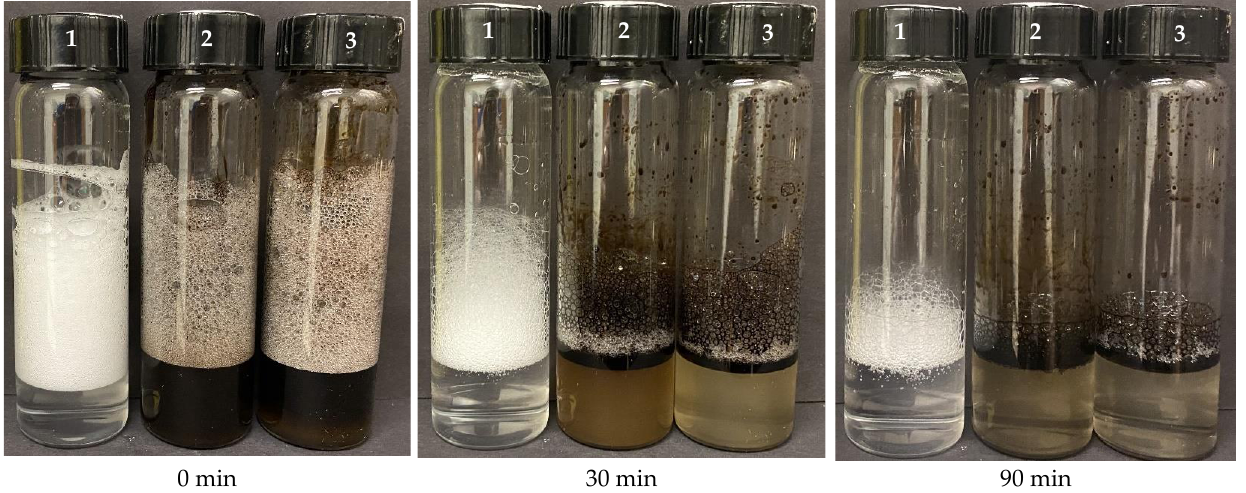
Figure 4. Bulk foam stability test with APG and crude oils from Unit-A and Unit-B: (1) no oil, (2) Unit-A oil, and (3) Unit-B oil.